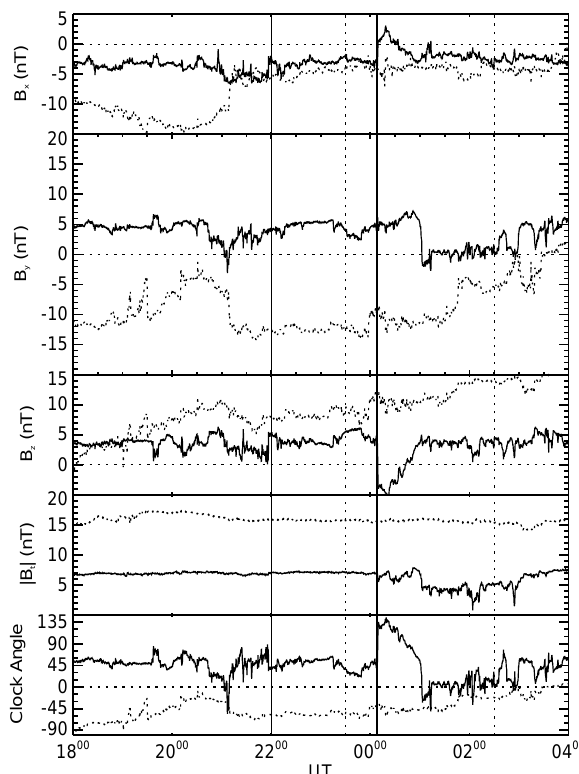
Fig. 1. Upstream interplanetary observations from the ACE space- craft for 18:00–04:00 UT on 21/22 February 2000 (dotted lines, In- terval–) and 26/27 April 2000 (solid lines, Interval+), lagged by 71 and 67min, respectively, to account for the propagation delay to the ionosphere. The top three panels show IMF data in GSM co-ordinates, and the bottom two panels show the field magnitude and clock angle. The clock angle is defined with respect to north, such that 0 ◦ corresponds to a transverse field purely in the + z di- rection (northward), ± 90 ◦ to ± y (respectively) and ± 180 ◦ to – z (southward). The vertical lines indicate key times described in the